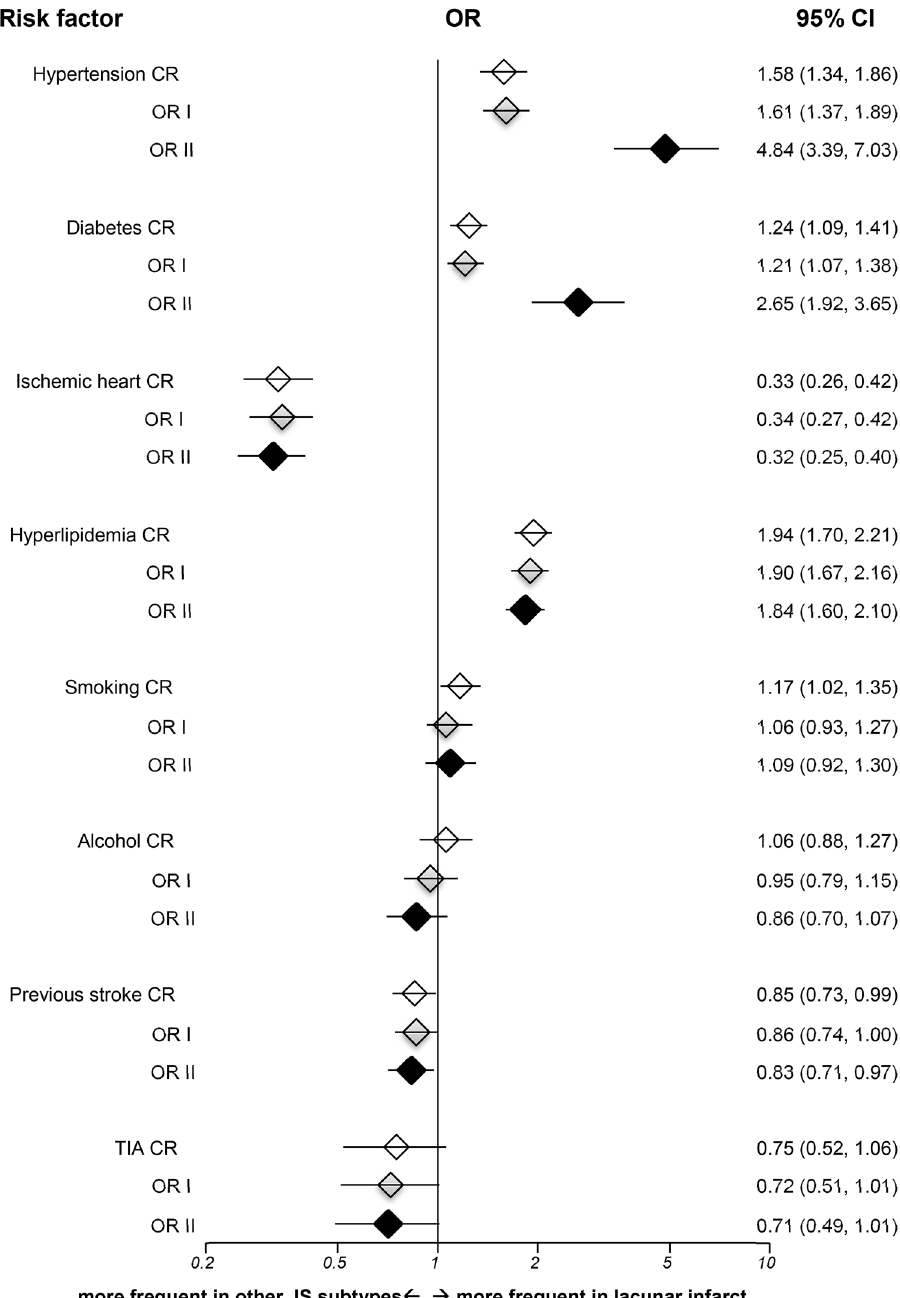
Figure 3. Risk factor analyses for lacunar infarct versus other ischemic subtypes in TOAST classification. IS = ischemic stroke; OR = odds ratio; CR = crude odds ratio; OR I = adjusted odds ratio I; OR II = adjusted odds ratio II; TIA = transient ischemic attack; CI = confidence interval; Horizontal lines represent 95% CIs. Diamonds represent pooled